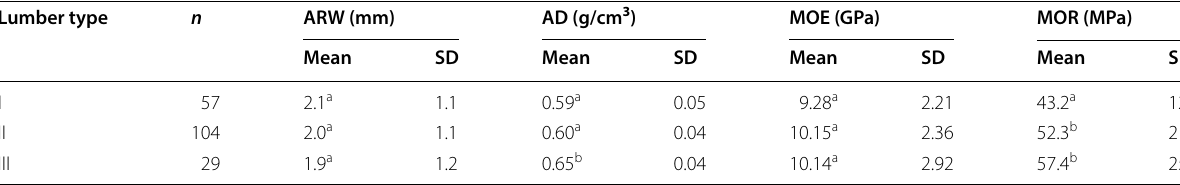
The same letters (a and b) followed by mean values indicate no significance at the 5% level according to the Tukey–HSD test. The values of the MOE and MOR were adjusted to the values at 15% moisture content n number of lumber pieces, ARW annual ring width, AD air-dry density at testing, MOE modulus of elasticity, MOR modulus of rupture, SD standard deviation, I lumber including pith at an almost-center position in cross-section, II lumber obtained near the pith (sometimes including pith on the surface area of the lumber), III lumber obtained from outer part of the logs (without pith)